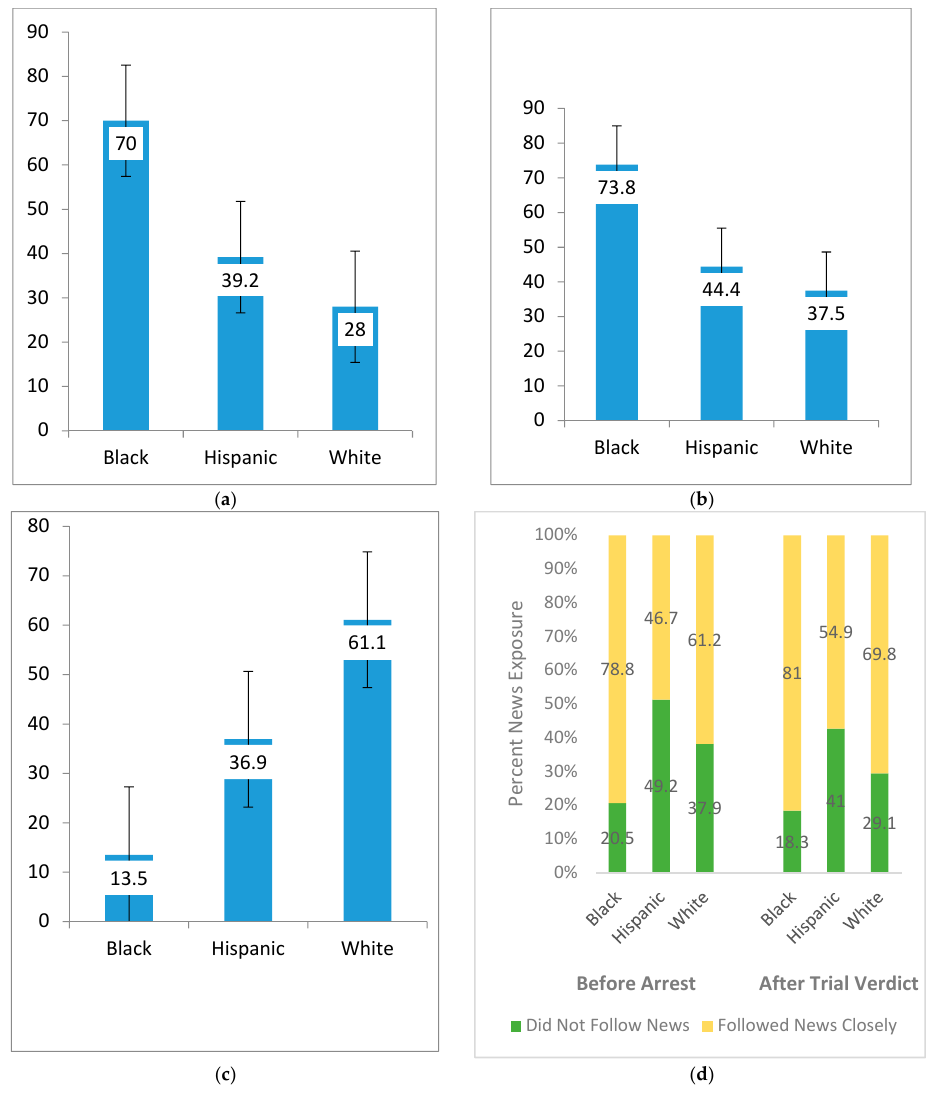
Figure 1. Percent of Respondents Indicating: ( a ) Justice System Is Biased Against African Americans; ( b ) Zimmerman Would Be Arrested If He Killed a White Person; ( c ) Jury Reached Correct Verdict in Zimmerman Trial; ( d ) Followed/Did Not Follow Martin/Zimmerman Incident. Note: The error bars in Panels A, B, and C represent the standard deviation of the responses from the mean for that group. Shorter bars indicate less variance in